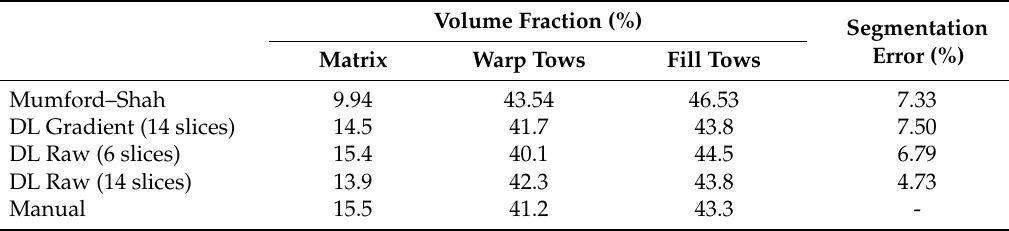
Figure 7. Demonstration of the segmentation results: ( a ) Raw image; ( b ) Ground truth; ( c ) Variational segmentation; ( d ) Deep learning for gradient images; Deep learning for raw image with 6 ( e ) and 14 ( f ) training slices. Table 1. Comparison of the manual and automatic